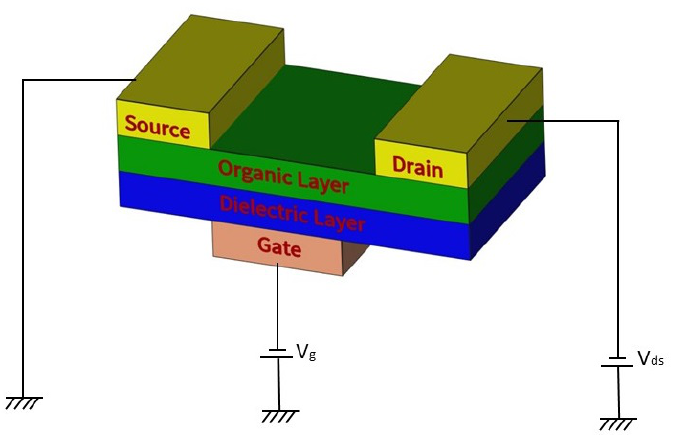
Figure 1. The architecture of organic TFT are similar, in terms of structures and functionalities, to that of traditional